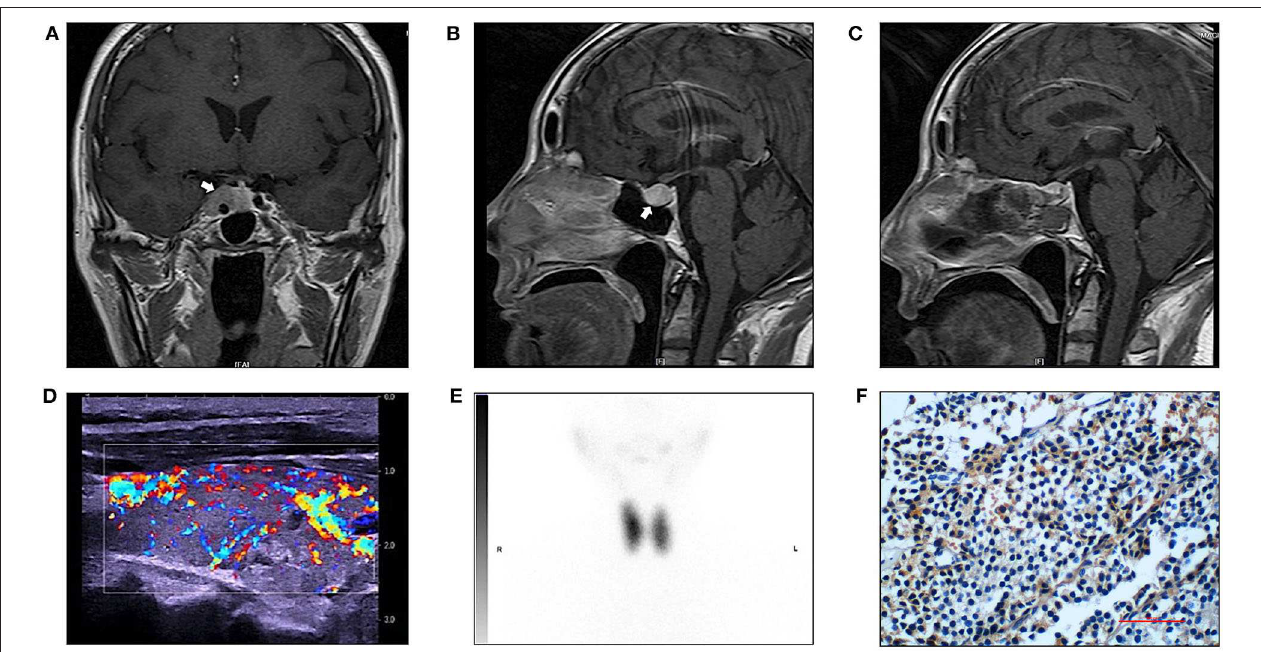
FIGURE 1 | Radiology imaging of the patient and immunostaining for TSH in the pituitary tumor. (A) Preoperative magnetic (MR) resonance image (T1-weight, sagittal view). White arrow pointing to a less enhanced area in the sella (17 × 15mm, arrow), involving the cavernous sinuses. (B) Preoperative magnetic (MR) resonance image (T1-weight, coronal view). (C) Postoperative MR image (T1-weight, sagittal view). (D) Thyroid ultrasound revealed a heterogenous parenchyma with rich blood flow and a nodule (ACR TR 3) located in the left lobe. The right thyroid lobe measures 5.00 × 1.70 × 1.87cm. The thyroid isthmus measures 0.23cm in AP dimension. The left thyroid lobe measures 5.08 × 1.77 × 1.97cm. (E) Radionuclide ( 99 mTcO 4 ) scan showed diffusely increased uptake, the ratio of uptake of the tracer in the thyroid to that in the background was 45 (right lobe) and 40 (left lobe). (F) Positive immunostainning for TSH in the pituitary tumor (magnification 400 ×